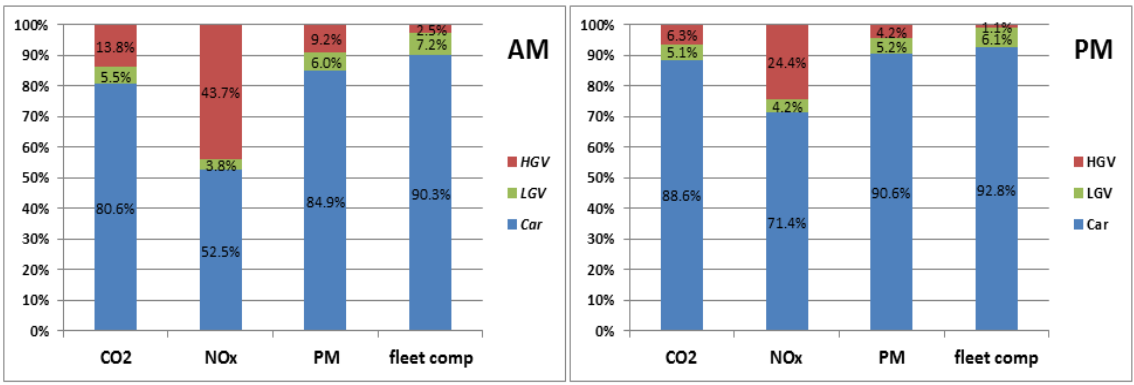
Figure 7. Source portion of CO 2 and pollution (NOx, PM)